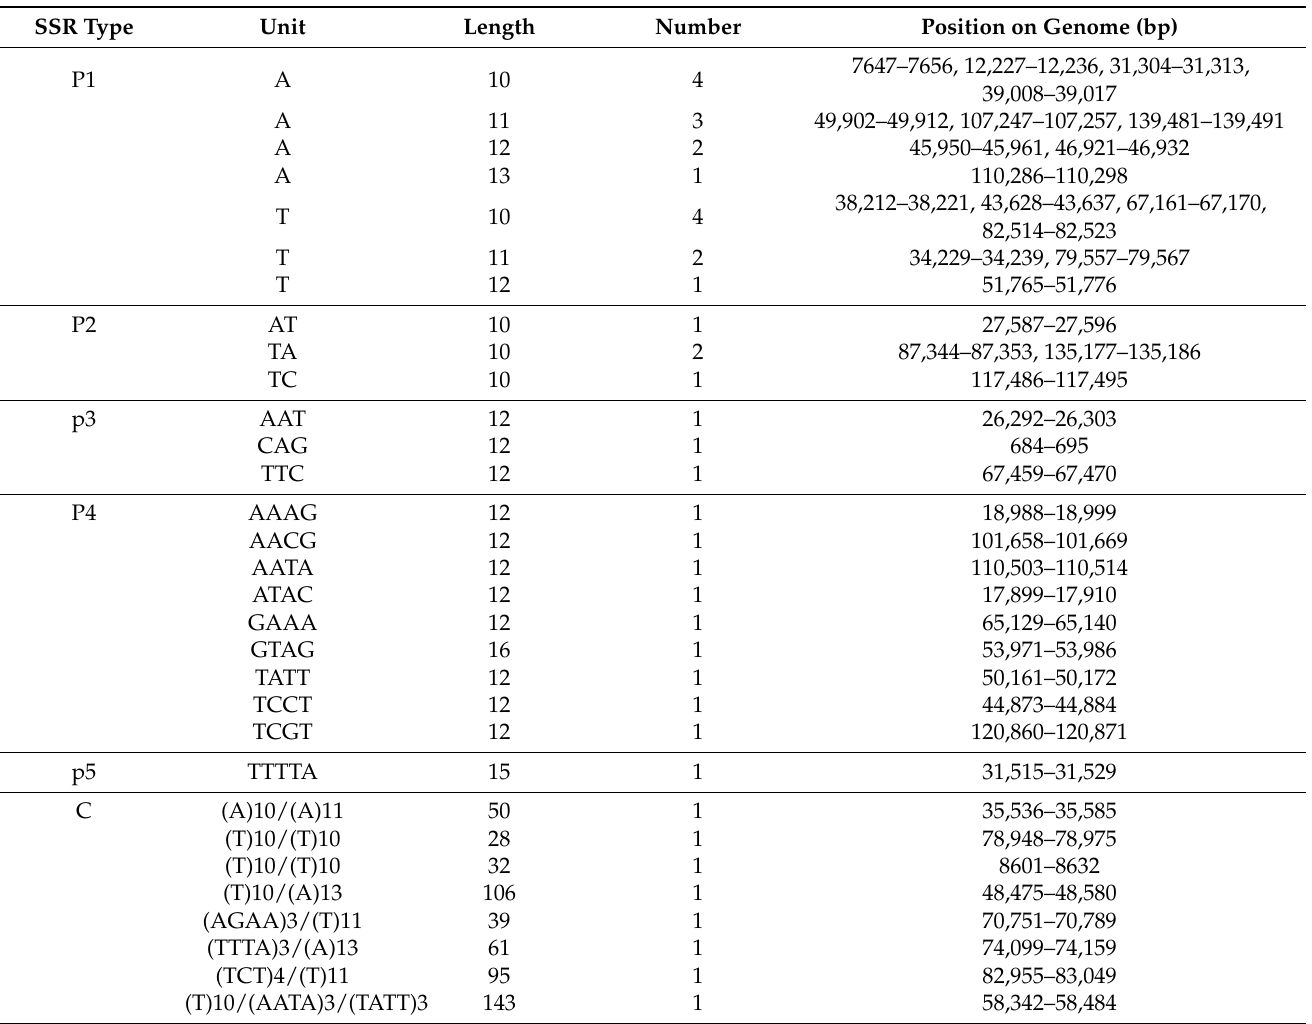
Table 3. Distribution of SSRs in the D. farinosus cp